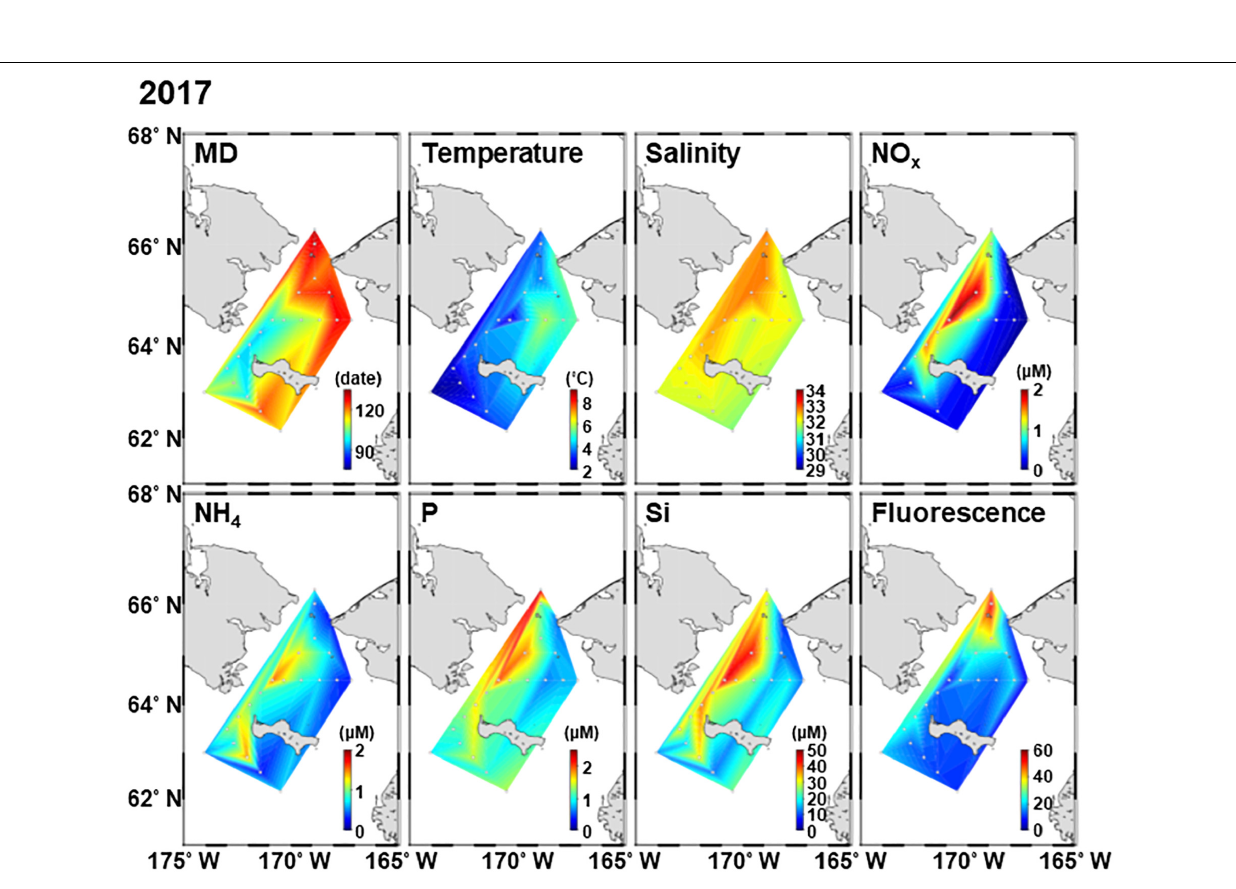
Frontiers in Marine Science |